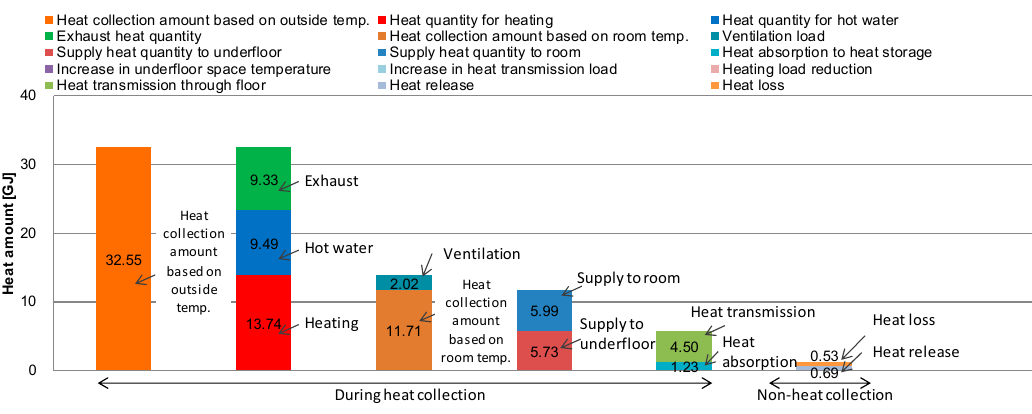
Figure 14. Heat flow from the heat collection of the air-based solar system.